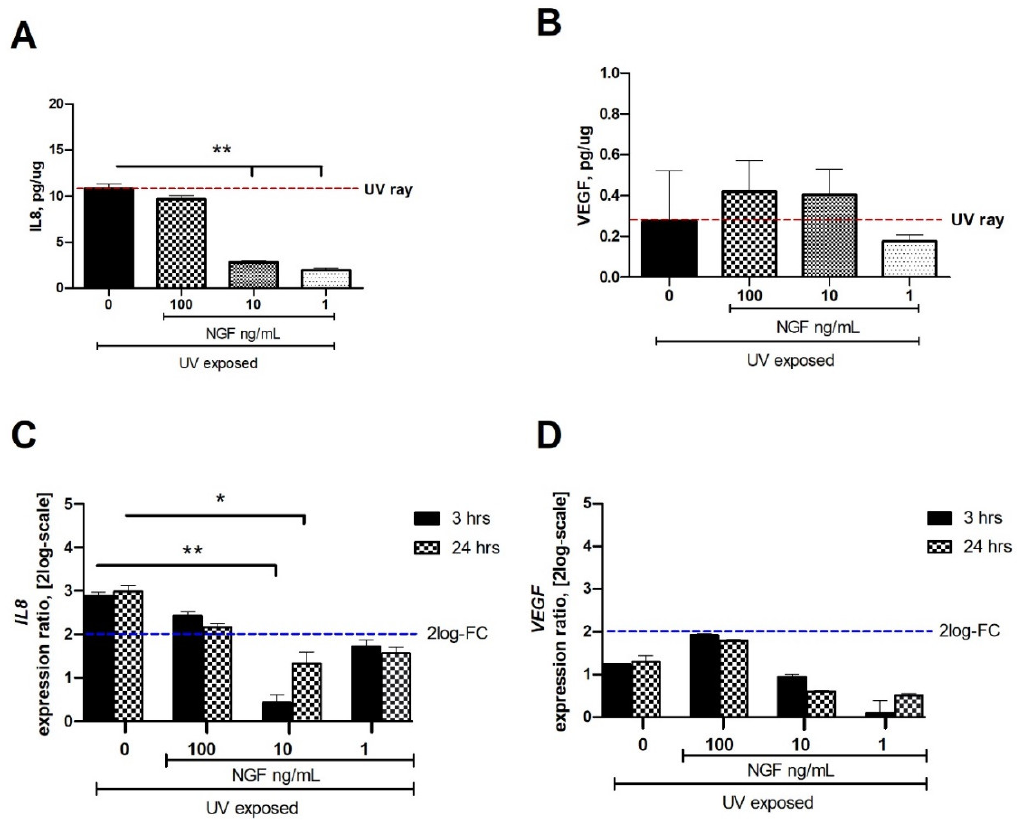
Figure 2. Effect of NGF supplementation on IL8 and VEGF protein and mRNA expression in UV- exposed conjunctival fibroblasts. Starved monolayers were UV-exposed either alone (0.05% FBS medium) or supplemented with NGF (1 – 10 – 100 ng/mL). Conditioned media ( A , B ) were collected after 24 h and analyzed (( A ); IL8/ELLA, ( B ); VEGF/ELISA). UV-exposed conjunctival FBs showed an increase in the cytokines and growth factor content in conditioned media, as compared to unexposed ones. RNA cell extracts collected at 3 h and 24 h from exposure showed an increased expression of transcripts for IL8 ( C ) and VEGF ( D ), as compared to UV-exposed ones, all calculated with respect to unexposed ones (REST analysis). Data represent mean ± SEM for all groups. REST-ANOVA fol- lowed by Tukey–Kramer post hoc analysis highlighted the significant effects indicated in the graphics (* p < 0.05 and ** p < 0.01) with respect to UV exposure; red dashed lines pointing at UV exposure and blue dashed lines for 2log-FC PCR biological significance.